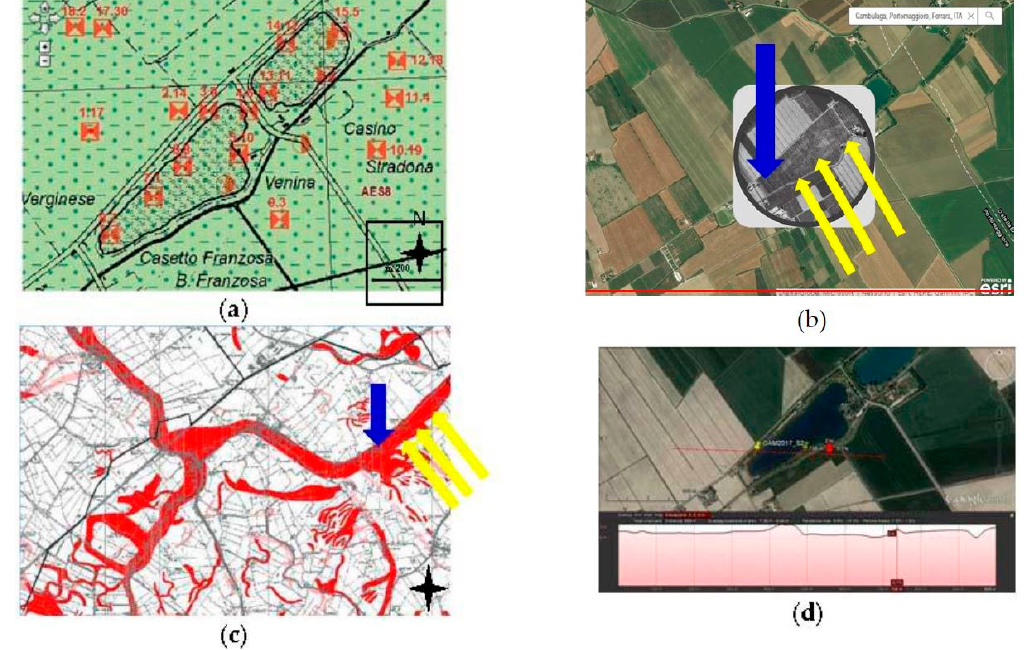
Figure 9. Lago Tramonto, Gambulaga, Portomaggiore (FE, Italy): ( a ) Extracted plan view from http://ambiente.regione.emilia-romagna.it/geologia/cartografia/webgis-banchedati (accessed on 30 November 2017) with the positioning of the 1990 drillings; ( b ) Palaeo-watercourse of the River Po on the site of the future quarry (1989), extracted from http://www.arcgis.com (accessed 1 December 2017), where the blue arrows indicate the archaeological site and the yellow arrows indicate the palaeo-alveo traces; ( c ) Palaeo-watercourses and floods (extracted from [3]); ( d ) Google Earth Image with position of the 2017 drillings and 1km altitude section crossing the two points of the drill.